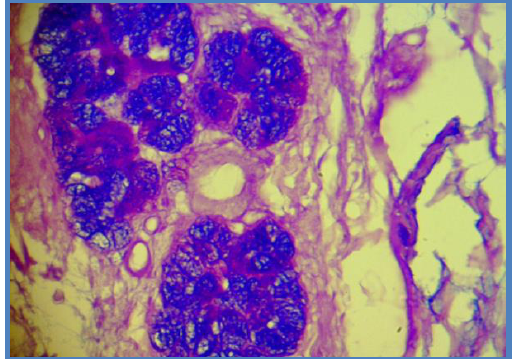
Figure (9): Histological section of nasal cavity (olfactory) showing : Alcian blue positive acini (Bowmann gland) (AB